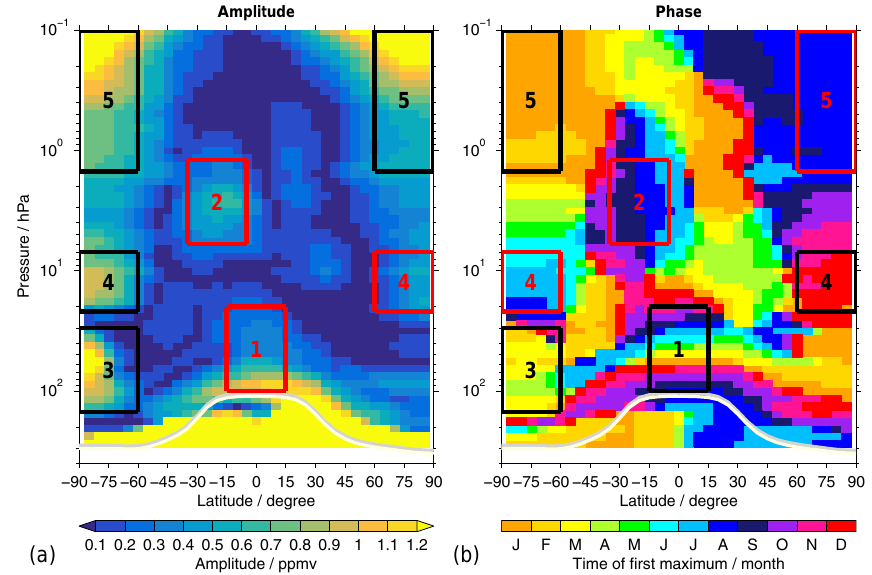
Figure 1. Example of the annual variation characteristics as a function of latitude and altitude based on the MLS data set. The left panel shows the amplitude and in the right panel the phase is shown. The phase is represented by the month in which water vapour exhibits its annual maximum in the regression fit. The light grey and white lines indicate the mean tropopause (2000–2014) derived from the MERRA reanalysis data. The red and black boxes mark characteristic features of the annual variation in water vapour that are described in more detail in the text. The colour variation of the boxes is for better contrast. White areas indicate that there are no